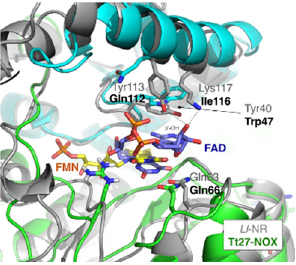
Figure 8 . Structural superimposition of nitroreductase from Idiomarina loihiensis L2TR (Ll-NR) and Tt27-NOX.